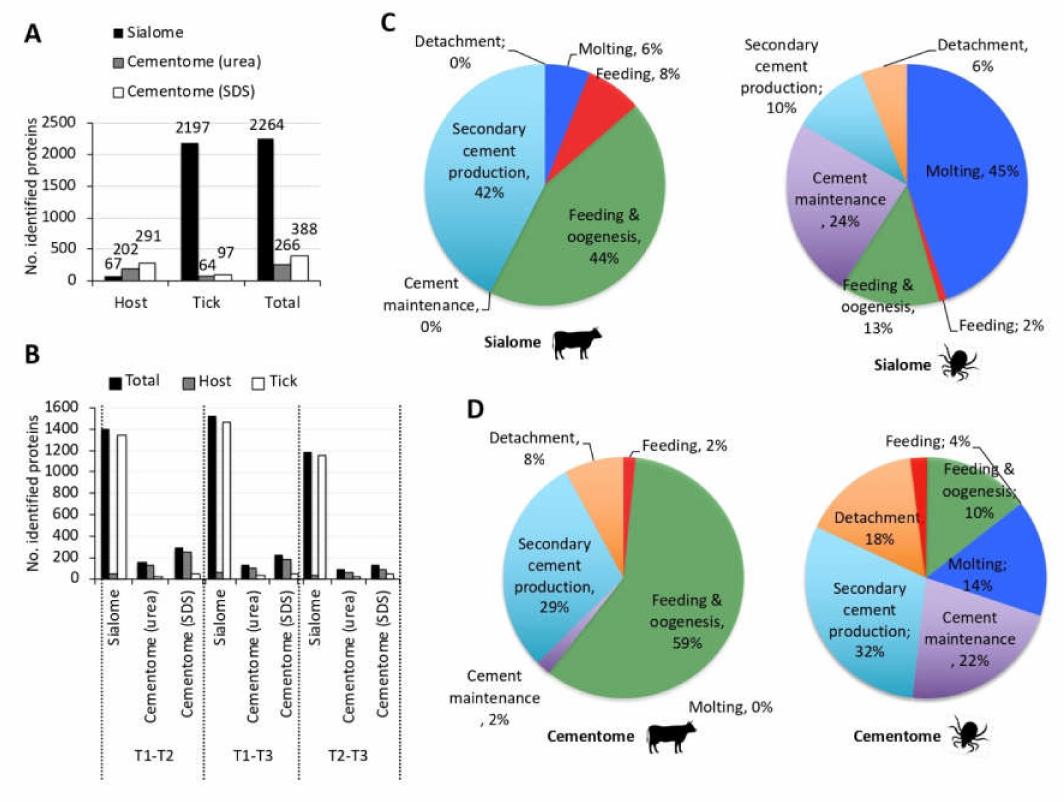
Figure 2. Protein representation profiles in tick sialome and cementome. ( A ) Number of host, tick, and total proteins identified in the sialome and cementome (proteins extracted with urea and sodium dodecyl sulfate (SDS)). ( B ) Host, tick, and total number of di ff erentially represented proteins ( p < 0.05; DataS4)identifiedinthesialomeandcementome(proteinsextractedwithureaandSDS).( C )Assignment of host and tick derived di ff erentially represented proteins identified in the sialome to putative categories of developmentally relevant processes based on their representation profile. ( D ) Assignment of host and tick derived di ff erentially represented proteins identified in the cementome to putative categories of developmentally relevant processes based on their representation profile. Proteins in the cementome extracted with urea and SDS were grouped together with unique non-redundant entries (Data